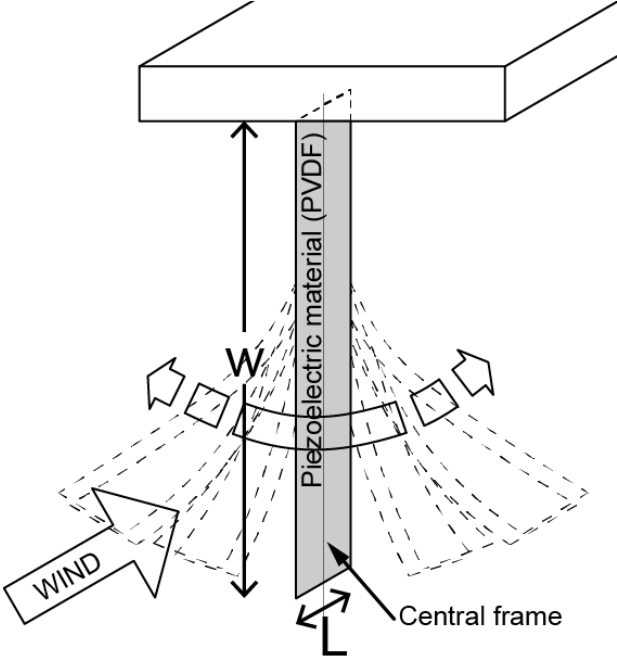
Figure 9. Piezoelectric material (PVDF) installation conceptual diagram.